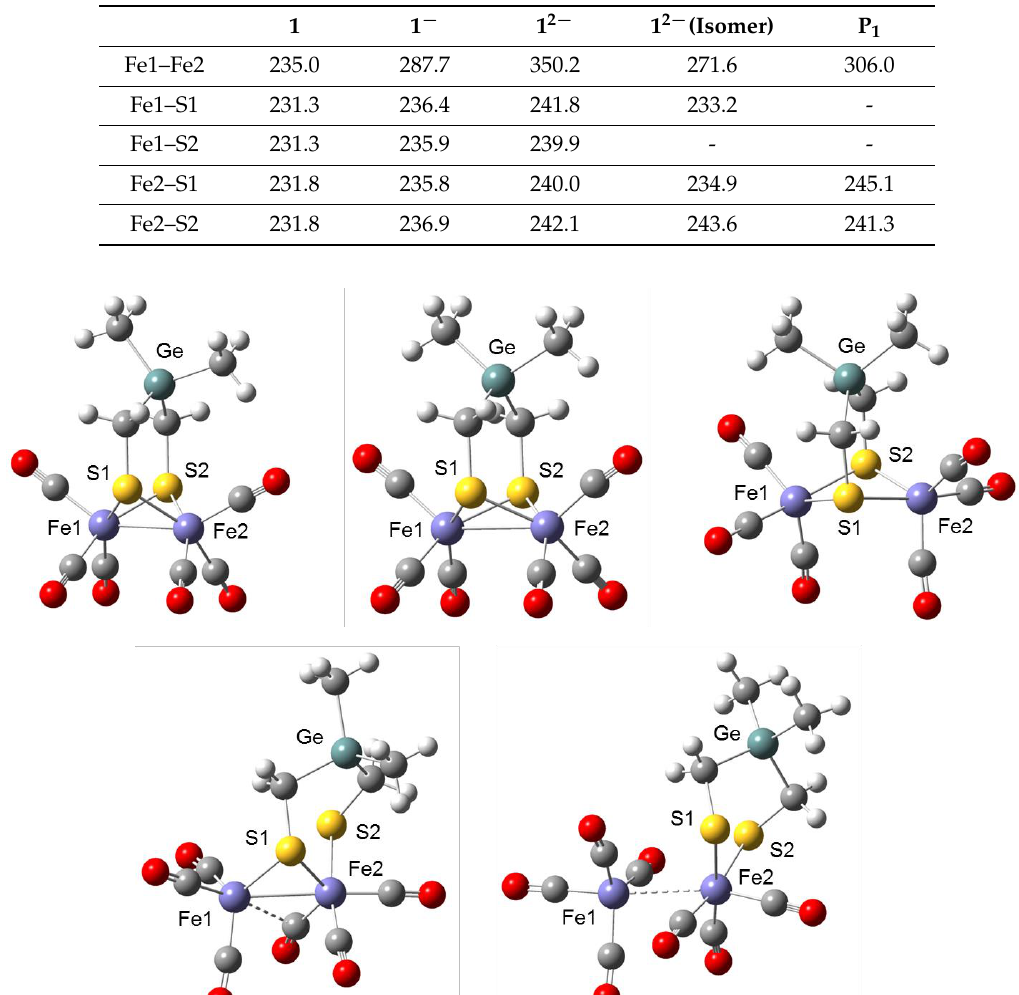
Table 1. Selected bond lengths and distances (pm) of calculated species.